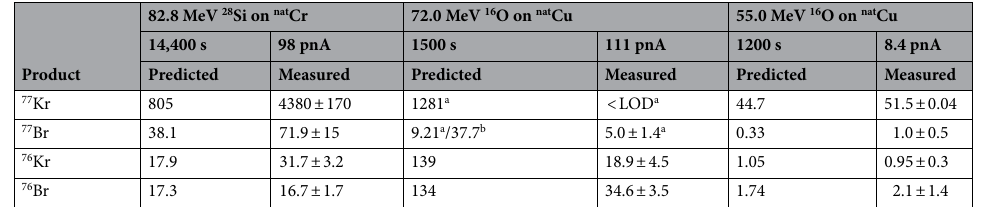
Table 2. Predicted and measured yields in kBq. a For the 72 MeV 16 O experiment, counting did not begin until approximately 18 h EOB. Consequentially, any 77 Kr produced would have decayed to a level too low to be detected prior to gamma spectroscopy beginning. The measured 77 Br therefore represents both directly produced 77 Br and the product of 77 Kr decay. For both isotopes, the predicted activities are for physical yield at EOB (using the same delivered current profile as the actual irradiation). The effects of simulation error on the predicted yields are negligible compared to variations in delivered beam and are ignored. b The 37.7 kBq of 77 Br represents the predicted EOB activity that would be found if all 77 Kr produced was allowed to decay to 77 Br, and then an EOB activity for 77 Br was determined by backfitting the decay from that point forward without decay-correcting for 77 Kr feeding.